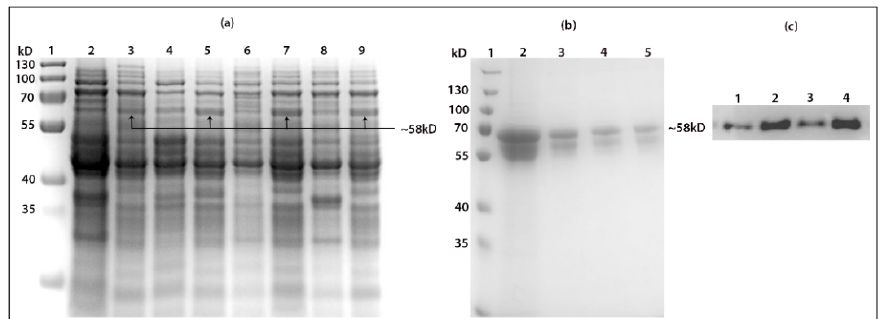
Figure 6. ( a ) SDS page of expressed N -terminally and C -terminally fused MLB and SNA-B to GFP. Lane 2, 4, 6 and 8 are non-induced protein samples: Lane 3, 5, 7 and 9 are induced protein samples from GFP + MLB, MLB + GFP, GFP + SNA and SNA + GFP fusion proteins, respectively. ( b , c ) SDS page of purifird GFP + MLB, MLB + GFP, GFP + SNA and SNA + GFP, respectively.